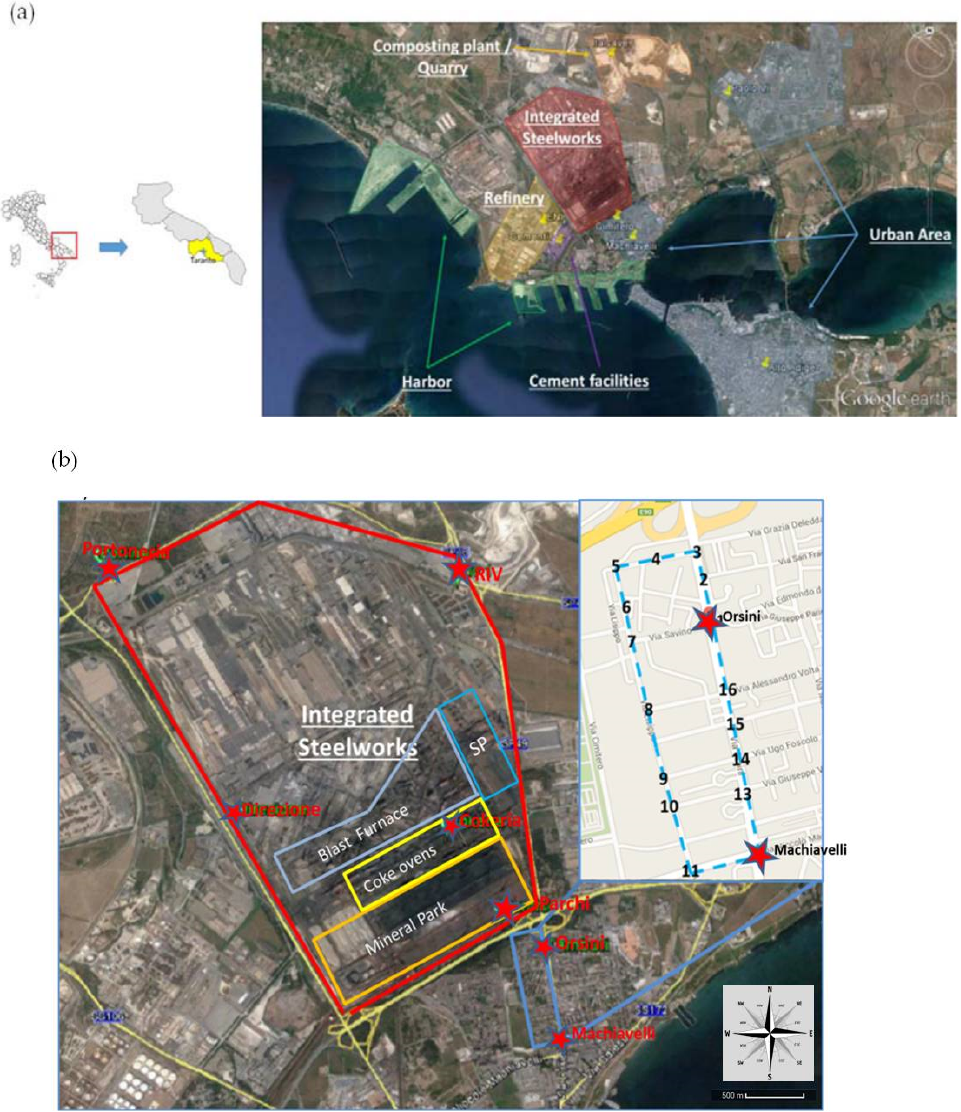
Figure 1. Location of the industrial area of Taranto with respect to Italy and the main industrial activities in this area ( a ); and the monitoring stations inside and surrounding the steel plant and the main emission sources in the steel plant ( b ). Mobile monitoring pathway (insert in (b)) .